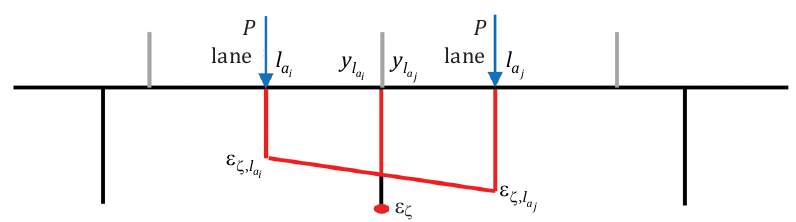
Figure 5. Calculation principle of the extreme value e ζ